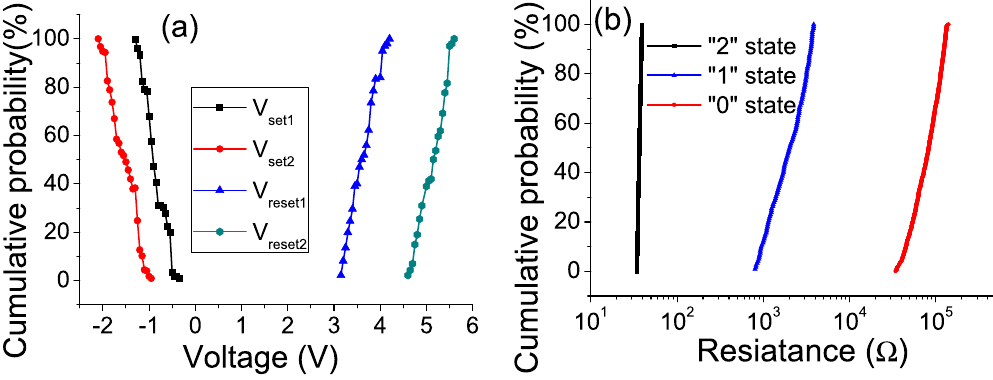
Figure 3. ( a ) The statistical distributions of the V set1 , V set2 , V reset1 and V reset2 . ( b ) The statistical distributions of the R 0 , R 1 and R 2 .